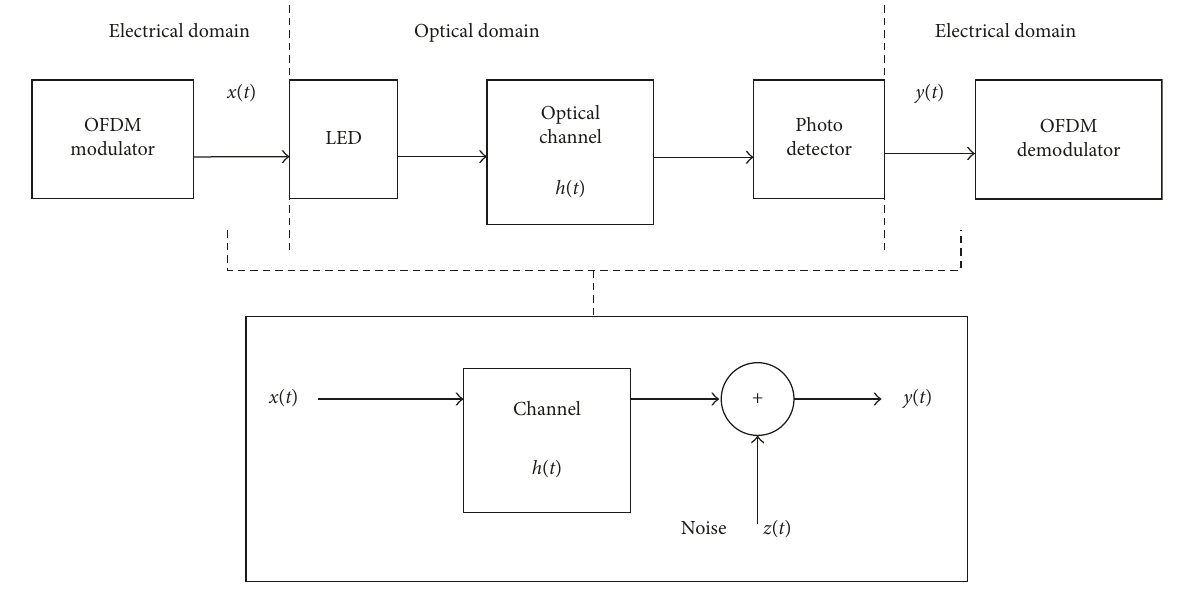
Figure 1: IM/DD system and its baseband